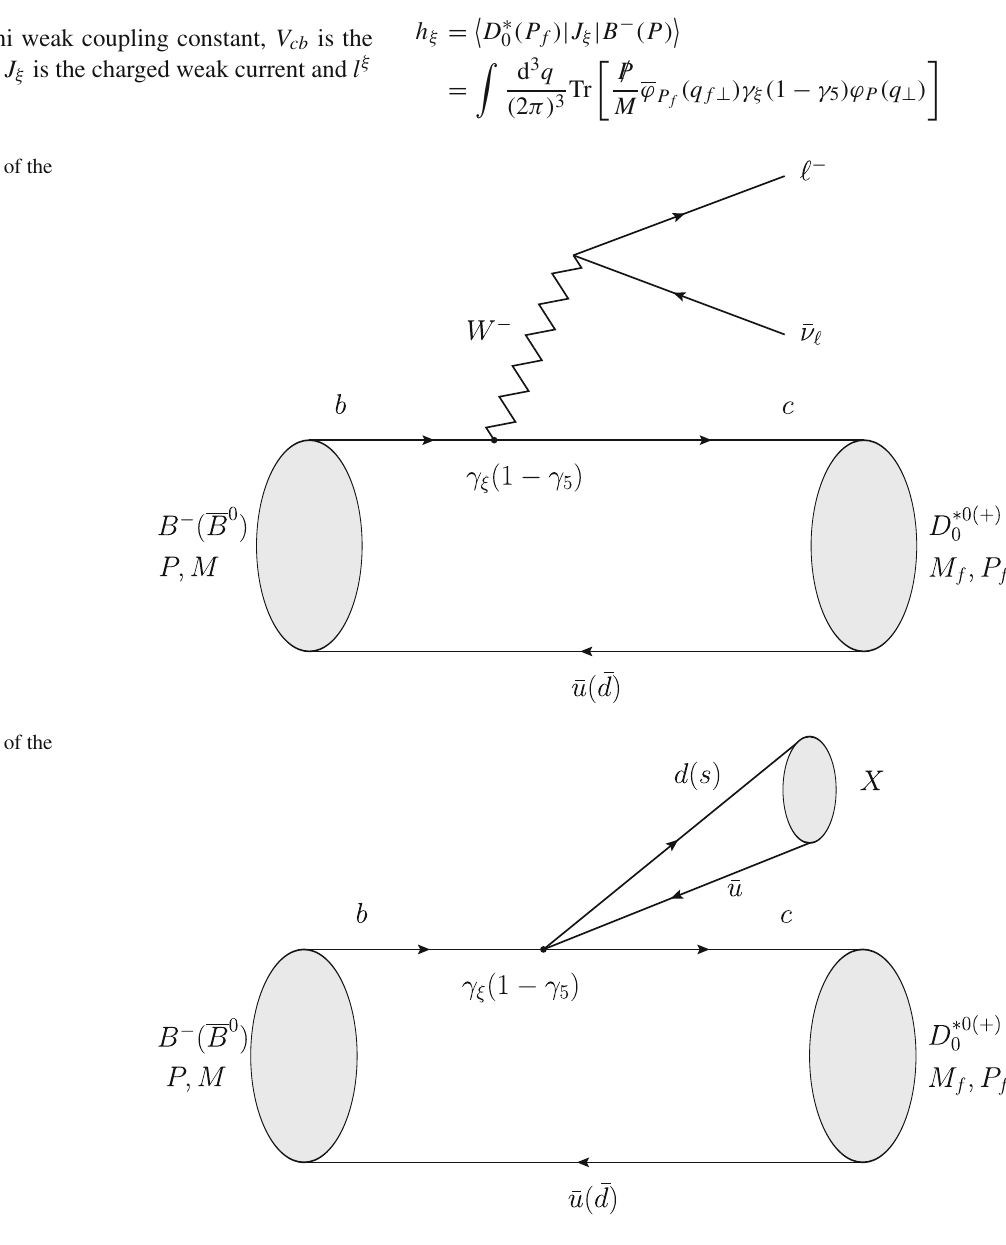
Fig. 1 Feynman diagram of the semi-leptonic decay